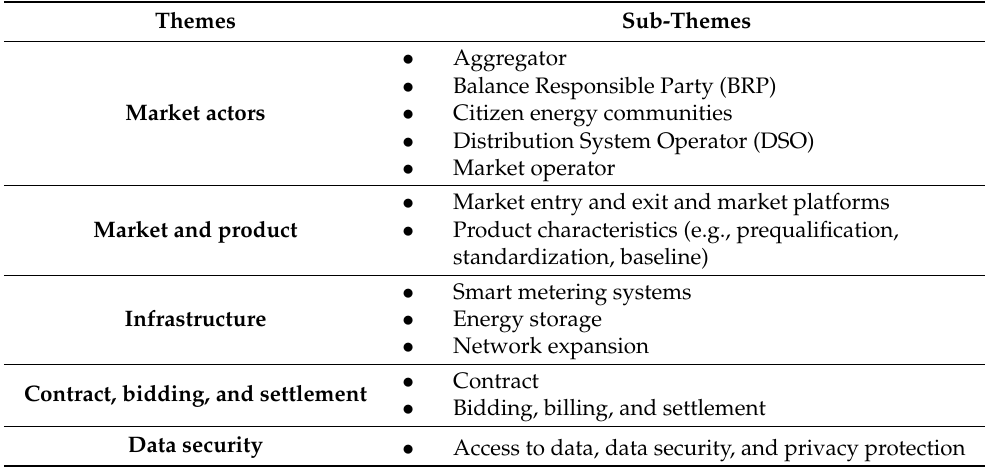
Table 1. The highlighted themes and sub-themes for regulation analysis in this